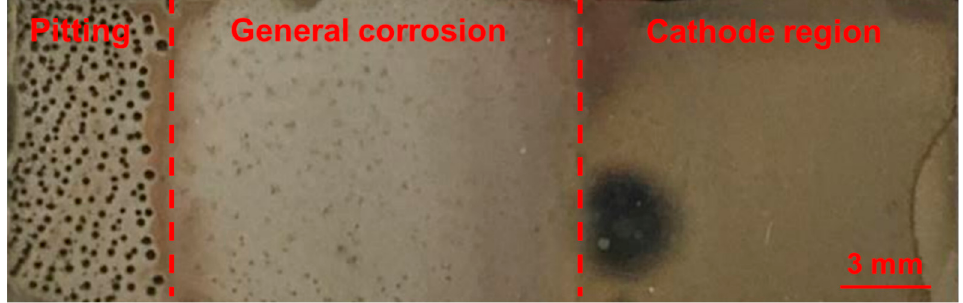
Figure 4. Appearance of the 30 mm long BPE after bipolar electrochemistry testing for 30 min, with the left side showing large pits at the oxidation edge and the right side showing the reduction edge.